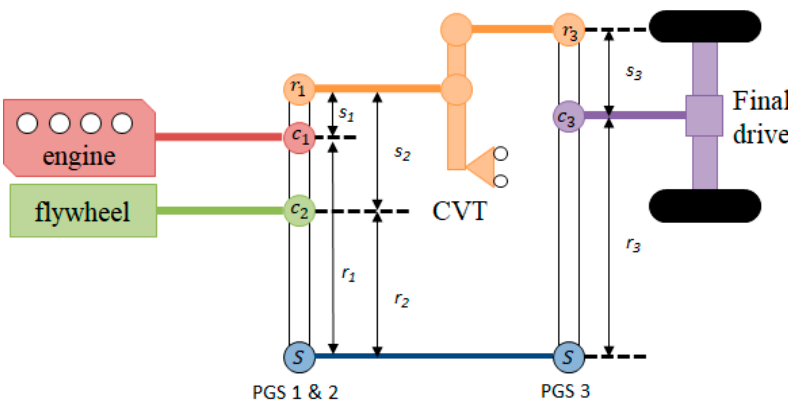
Figure 2. The PS-FHV configuration, consisting of three PGSs and one CVT. 2.1. The PS-FHV Lever Analogy To explain the working principles of the PS-FHV, a lever diagram of the PS-FHV system and power analysis can be used. The PGS and CVT are represented by a three-node lever [22,23] and the